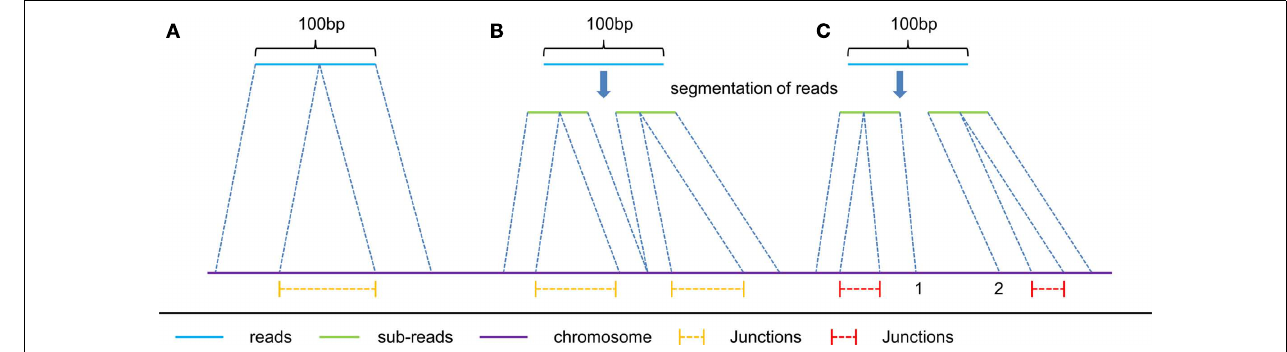
all its mapped sub-reads connecting with each other, at the same segmentation point on the reference. Unlike read (B) , read (C) has its mapped sub-reads not connecting with each other at the same segmentation points on the reference. Consequently, yellow color junctions are more reliable than the red color ones.